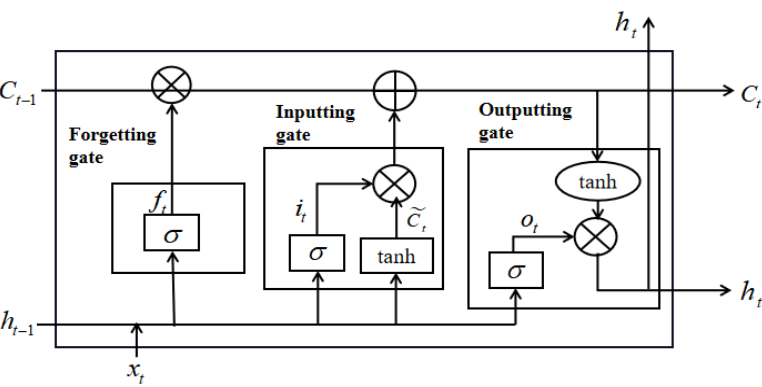
Figure 1. The structure diagram of the memory unit. In Figure 1, ⊗ represents matrix multiplication and ⊕ represents matrix addition. A two-arrow merge means vector merger, and a one-arrow split means vector replication. For example, the upper h t indicates the output data of the output gate, while the right h t is the same as the former, but indicates the transfer to the next memory